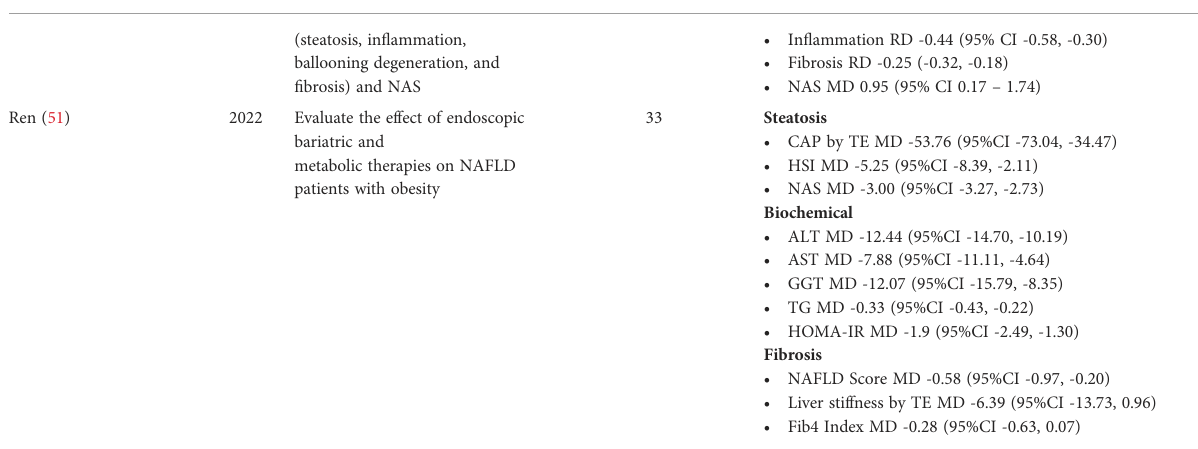
NAFLD non-alcoholic fatty liver disease; NASH non-alcoholic steatohepatitis; WMDI weighted mean decrease in incidence; WMR weighted mean reduction; AST aspartate aminotransferase; ALT alanine aminotransferase; ALP alkaline phosphatase; NAS NAFLD activity score; ES effect size; MD mean difference; RD risk difference; RYGB Roux-en-Y gastric bypass; SG sleeve